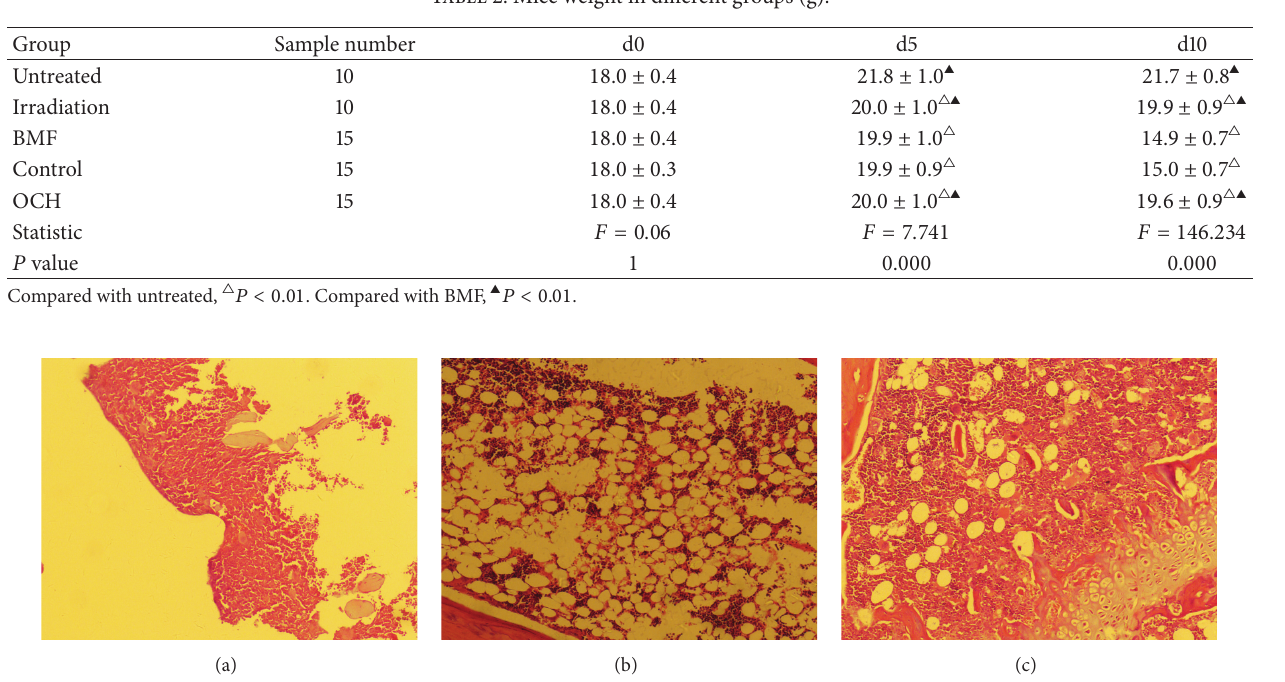
Figure 3: Pathology evaluation of bone marrow on d60 in mice with untreated (a), BMF (b), or OCH (c). On d60 after BMF induction, mice were sacrificed. Bone marrow was collected, fixed, embodied, sectioned, stained with H&E, and examined by using an Olympus microscope.